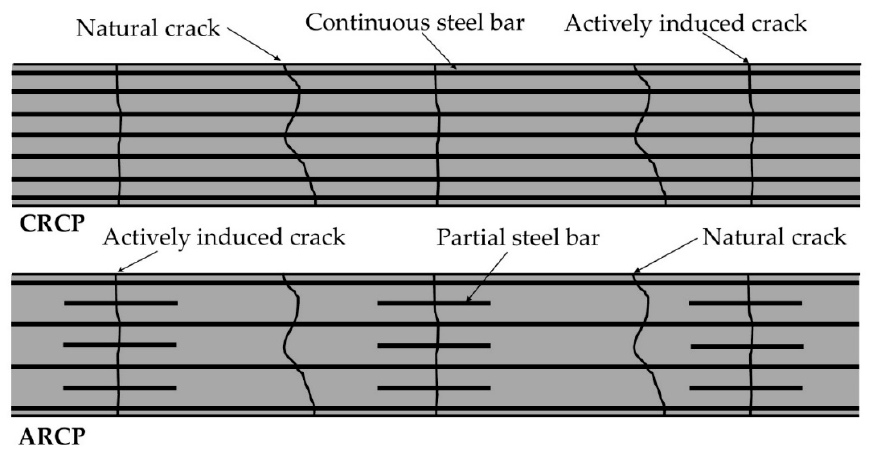
Figure 15. Demonstration of reinforcement layout of ARCP.